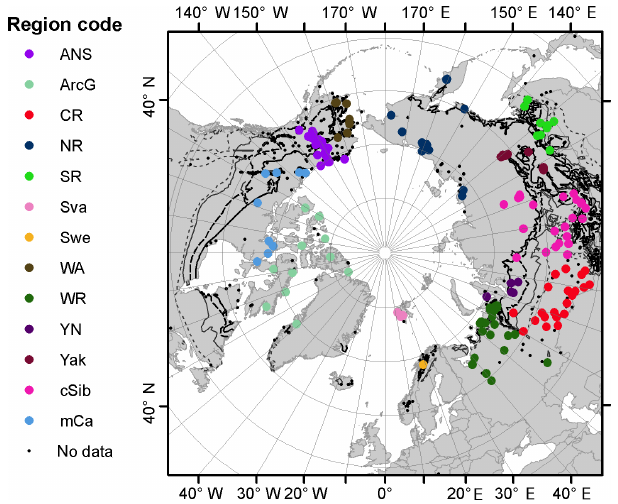
Figure 1. Map of used GTN-P boreholes with region class. “No data” refers to sites without publicly available data or sites which failed the selection criteria. ANS – Alaska Highway transect and North Slope; ArcG – Canadian High Arctic and Greenland; CR –